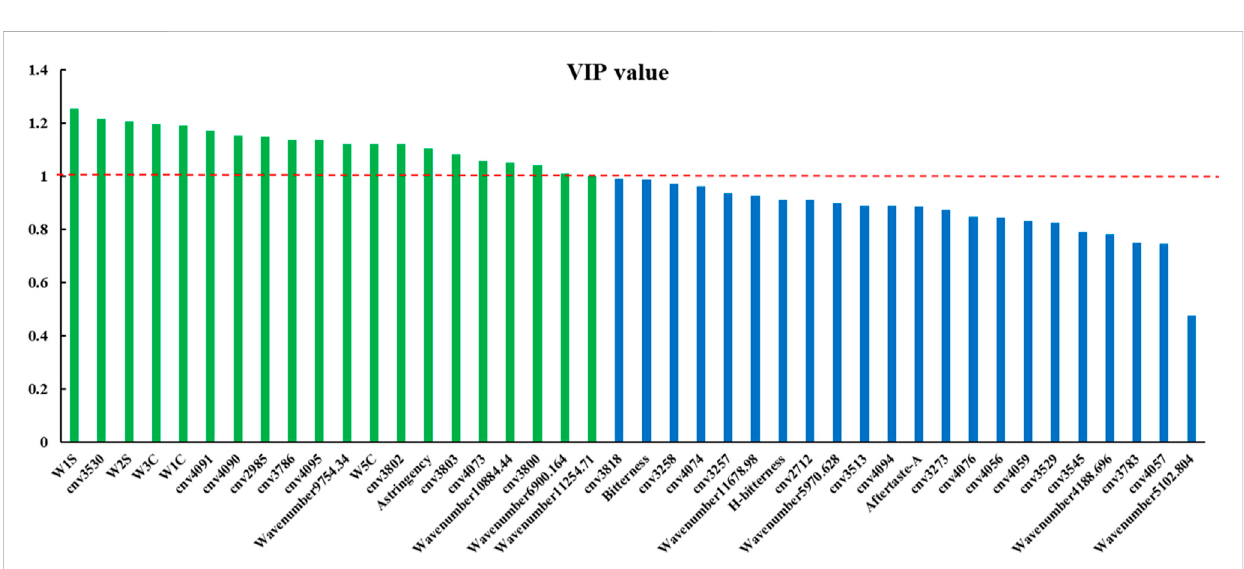
FIGURE 9 VIP value of each variable in the four-source fusion PLS-DA model (cnv: color number